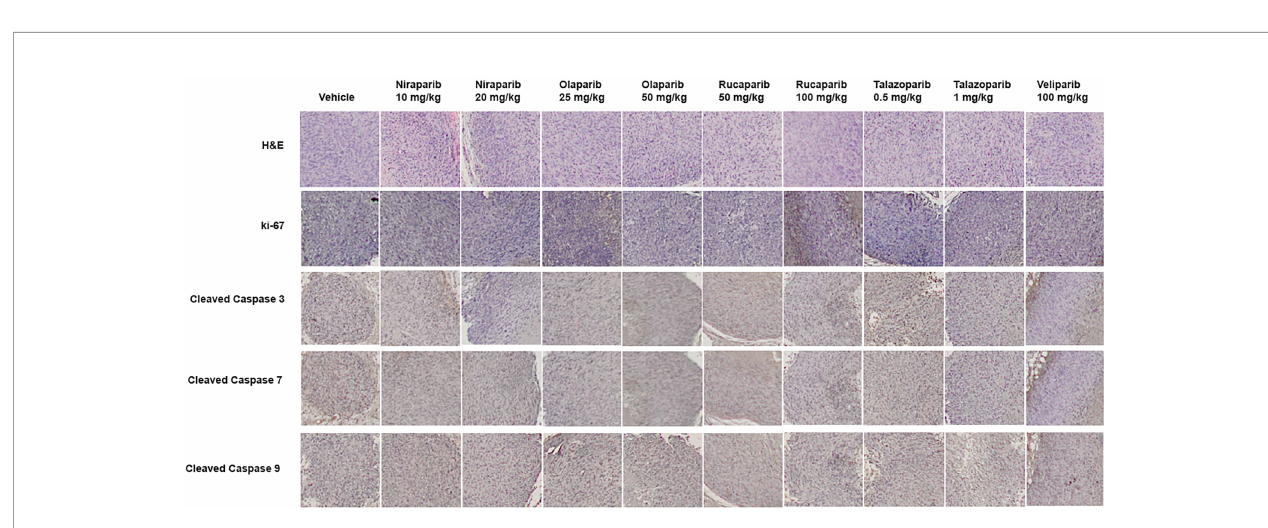
FIGURE 4 | Treatment with PARPi induced apoptotic markers in RCC xenografts. RCC xenograft tissues were subjected to immunohistochemical analyses using antibodies against the proliferation marker ki-67 and the apoptotic markers cleaved caspases 3, 7, and 9. Representative images are shown in each group. Treatment with PARPi inhibited ki-67 and induced higher levels of cleaved caspases 3, 7, and 9.